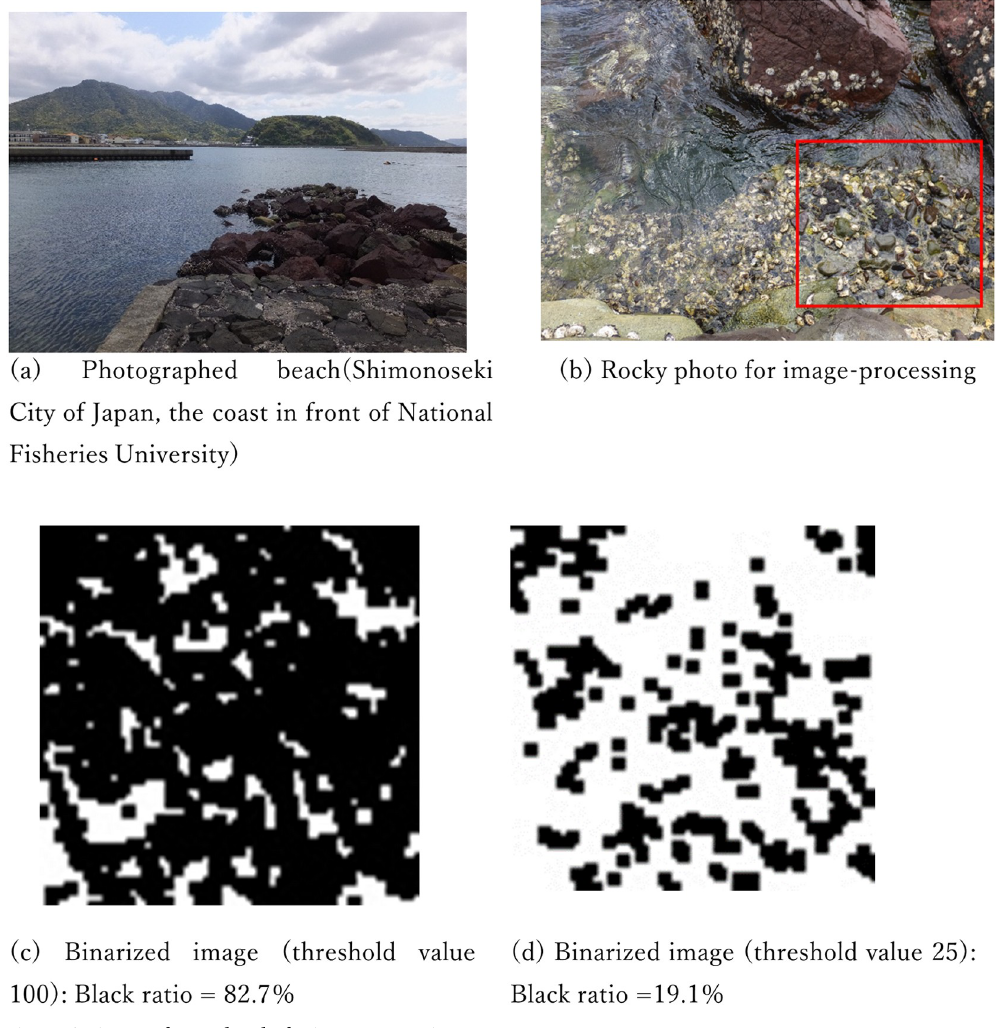
Fig 12. An image of coastal rocks for